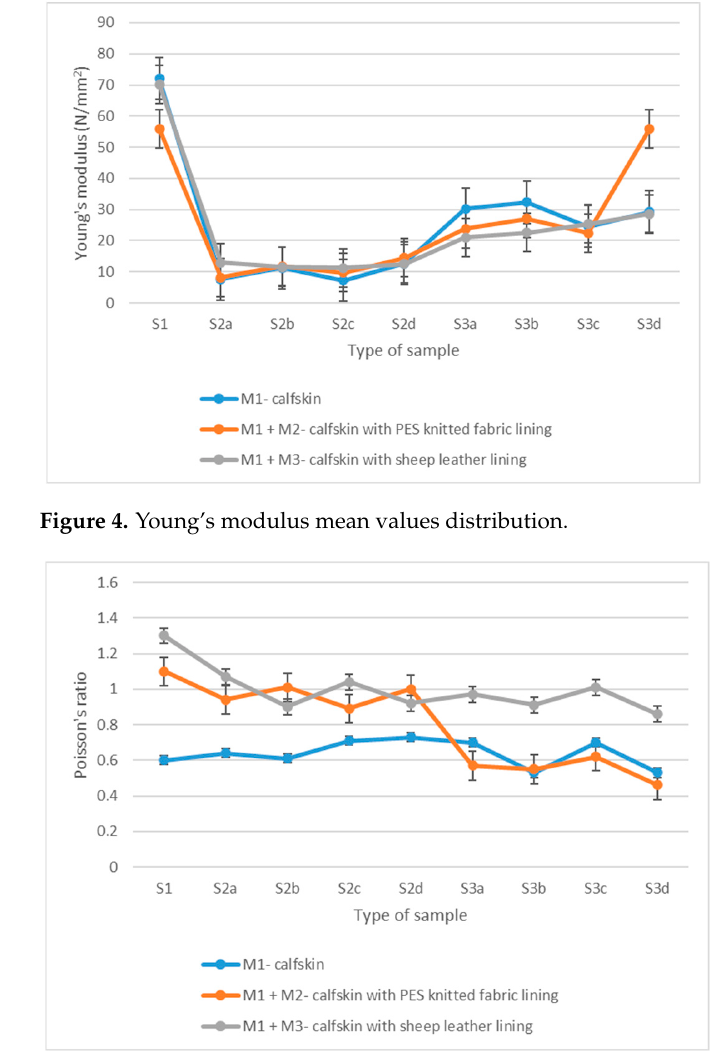
Figure 5. Poisson’s ratio mean values distribution.